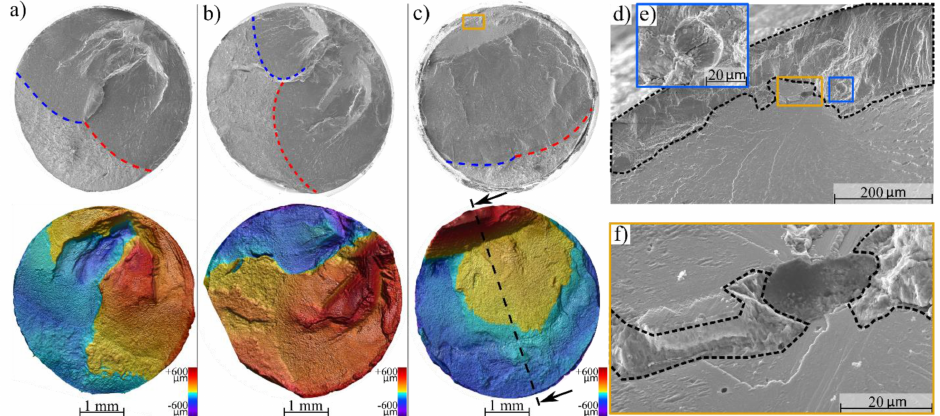
Figure 6. Fracture surface observations using SEM and CLSM of the EBM material. ( a ) Overview of an EBM sample deformed at σ a = 158 MPa (N f = 6.5 × 10 6 ). ( b ) Overview of an EBM sample deformed at σ a = 149 MPa (N f = 4.5 × 10 7 ). ( c ) Overview of an EBM sample deformed at σ a = 209 MPa including the cutting plane for further preparation of the cross section and EBSD observation (see Figure 8). ( d ) Detailed SEM image of the region of crack initiation marked in ( c ) including the rough area of the fracture surface. ( e ) Defect caused by gas porosity marked in ( d ). ( f ) Assumed origin of crack initiation marked in ( d ) including the rough area of the fracture